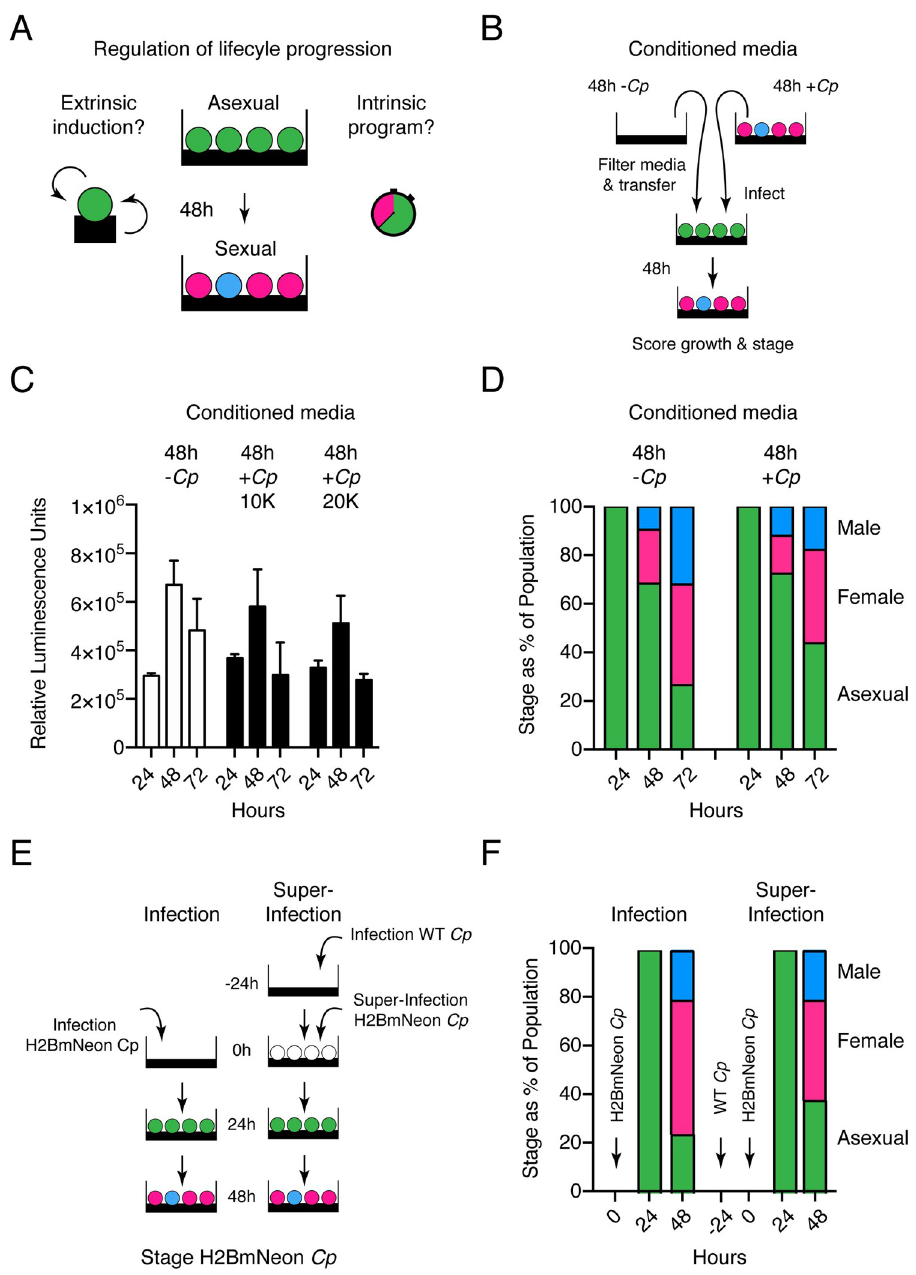
Fig 1. Sexual differentiation of C . parvum is not dependent upon a secreted factor. (A) Schematic representation of both the induction and program hypotheses of C . parvum sexual differentiation. (B) Schematic representation of the conditioned media experiment. Briefly, media was conditioned for 48 hours in the presence of HCT-8 host cells with or without C . parvum infection. Conditioned media was passed through a 0.45- μ m filter and then used for new infections that were scored for growth (C) and sexual differentiation (D) . (C) Growth assay by luminescence for C . parvum growth in conditioned media. (D) Stage scoring of C . parvum at 24, 48, and 72 hours postinfection when grown in conditioned media. (E) Schematic representation of super-infection experiment. Briefly, HCT-8 cells were infected with H2BmNeon parasites that were previously infected for 24 hours with WT parasites or not previously infected. Both the primary infection (WT) and super-infection (H2BmNeon) were scored for parasite life stage at indicated time points postinfection. (F) Stage scoring and life cycle progression of C . parvum super-infection experiment. Underlying data are provided in the Supporting information as S1 Data. WT, wild type.